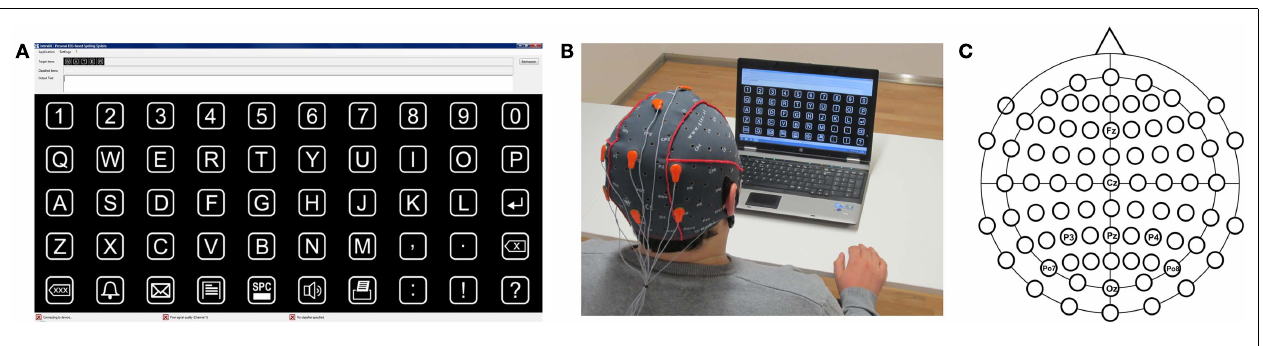
FIGURE 1 | (A) Shows the intendiX spelling matrix at the beginning of a “copy-spelling” run.The phrase “WATER” is presented at the top of the screen.The “W” is highlighted, indicating that it is the target letter. (B) The ground is on the left mastoid, and the reference is on the right